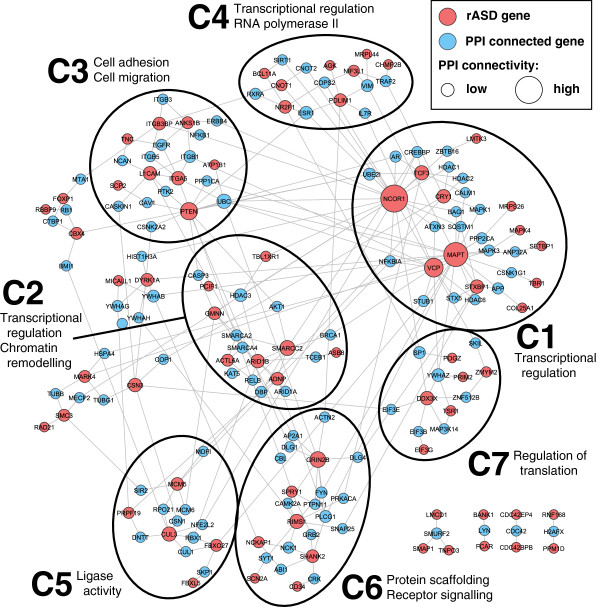
Clustering by enrichment and protein-protein interaction (PPI). The rASD genes are seeded into the PPI network presented in [6], represented by red nodes, with size proportional to the number of connections. The blue nodes are immediate intermediate proteins [36]. The network was clustered using organic clustering methods implemented in yEd [44] rASD, risk autism spectrum disorder.